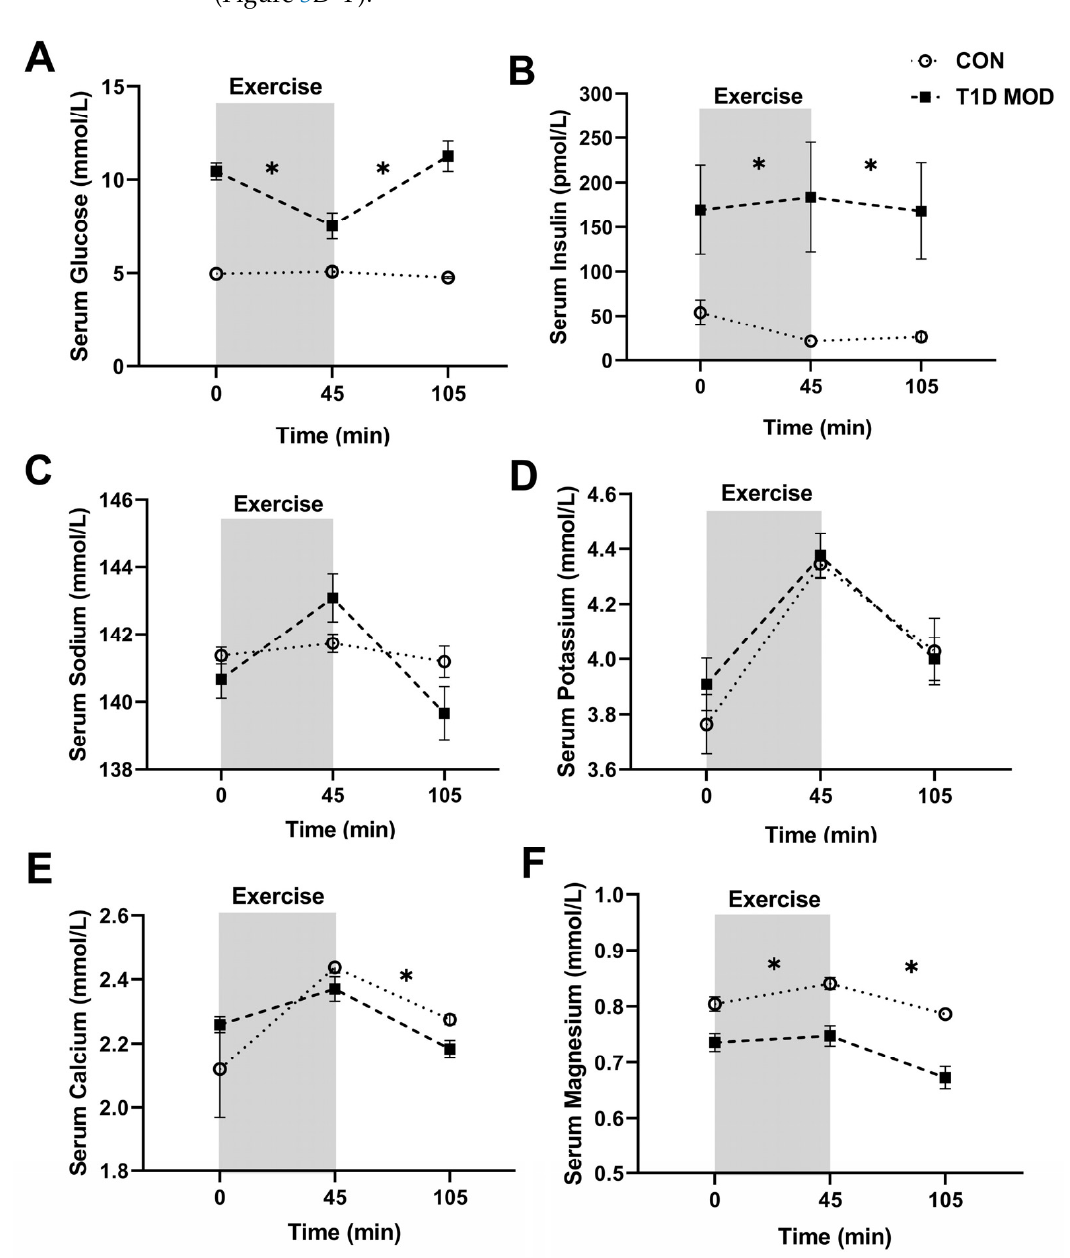
Figure 3. Serum concentrations (mean ± SEM) of glucose ( A ), insulin ( B ), sodium ( C ), potassium ( D ), calcium ( E ), and magnesium ( F ) before exercise (time 0), at the end of exercise (45 min), and at the end of the 60 min recovery (105 min) in CON (white circles) and T1D MOD (black squares). * shows significant differences (treatment effect) between CON and MOD from the beginning to the end of exercise and from the end of exercise to the end of recovery, compared by ANOVA.